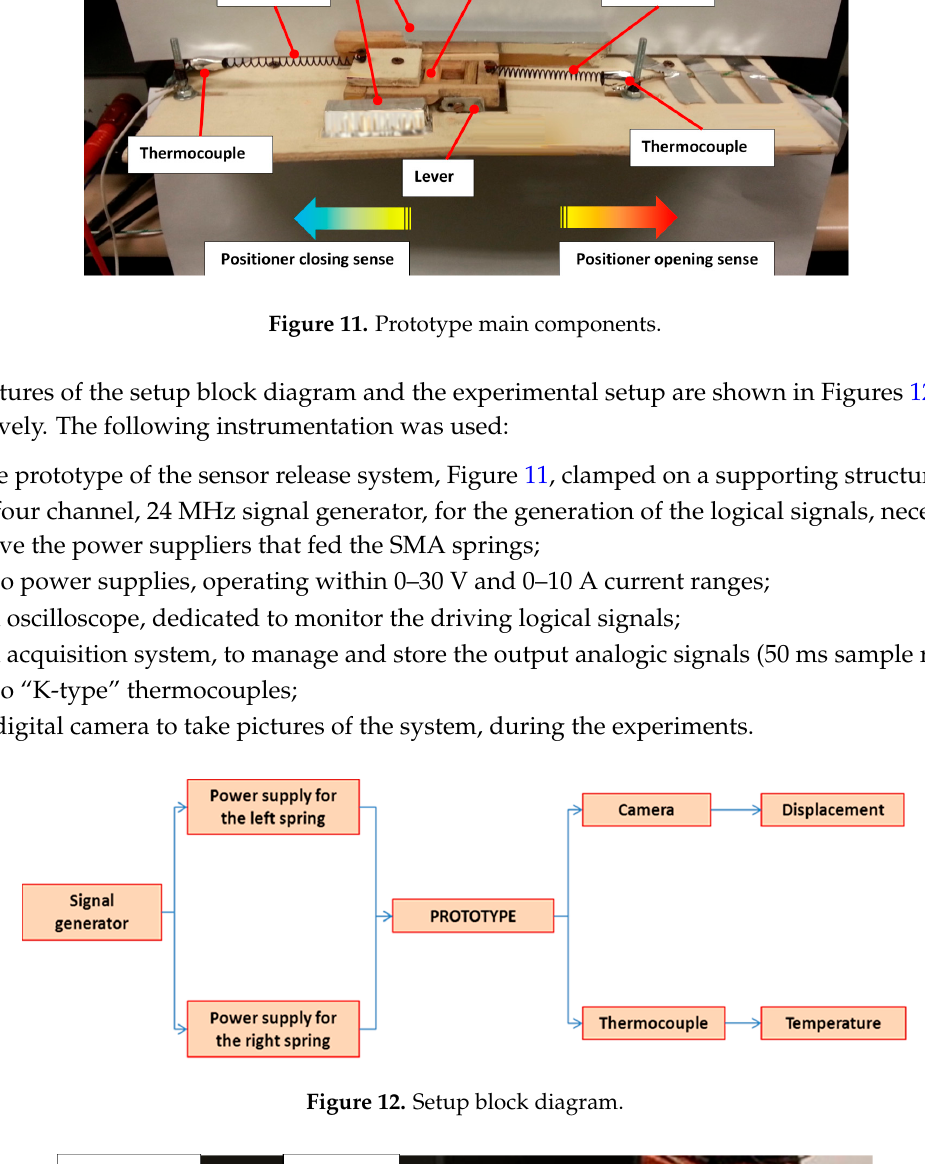
Figure 12. Setup block diagram.